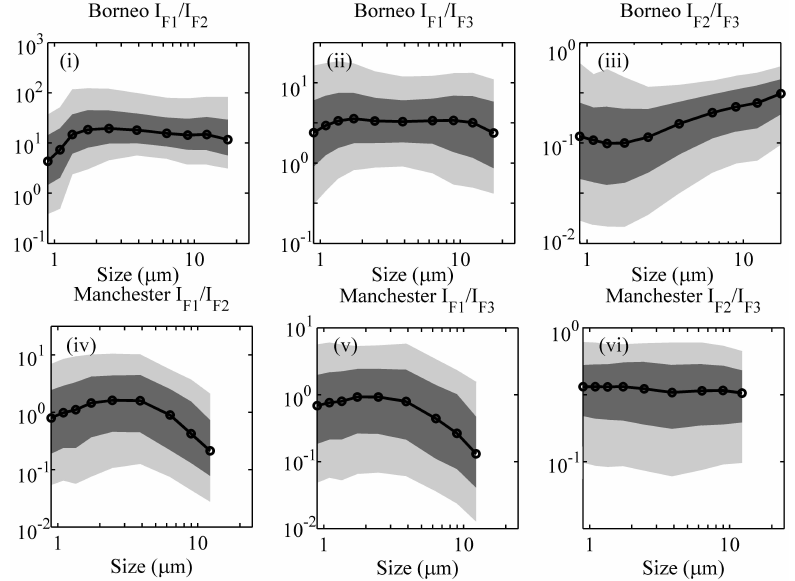
Fig. 9. Size-resolved fluorescence intensity and ratios using each combination of fluorescence channels in Borneo (upper panel) and Manch- ester (lower